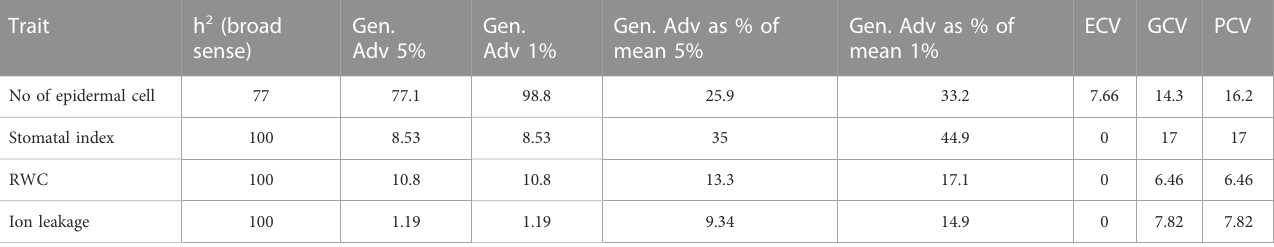
TABLE 3 ( Continued ) Genetic variability parameters for 19 quantitative traits evaluated on 20 foxtail millet landraces along with four released cultivars. Trait